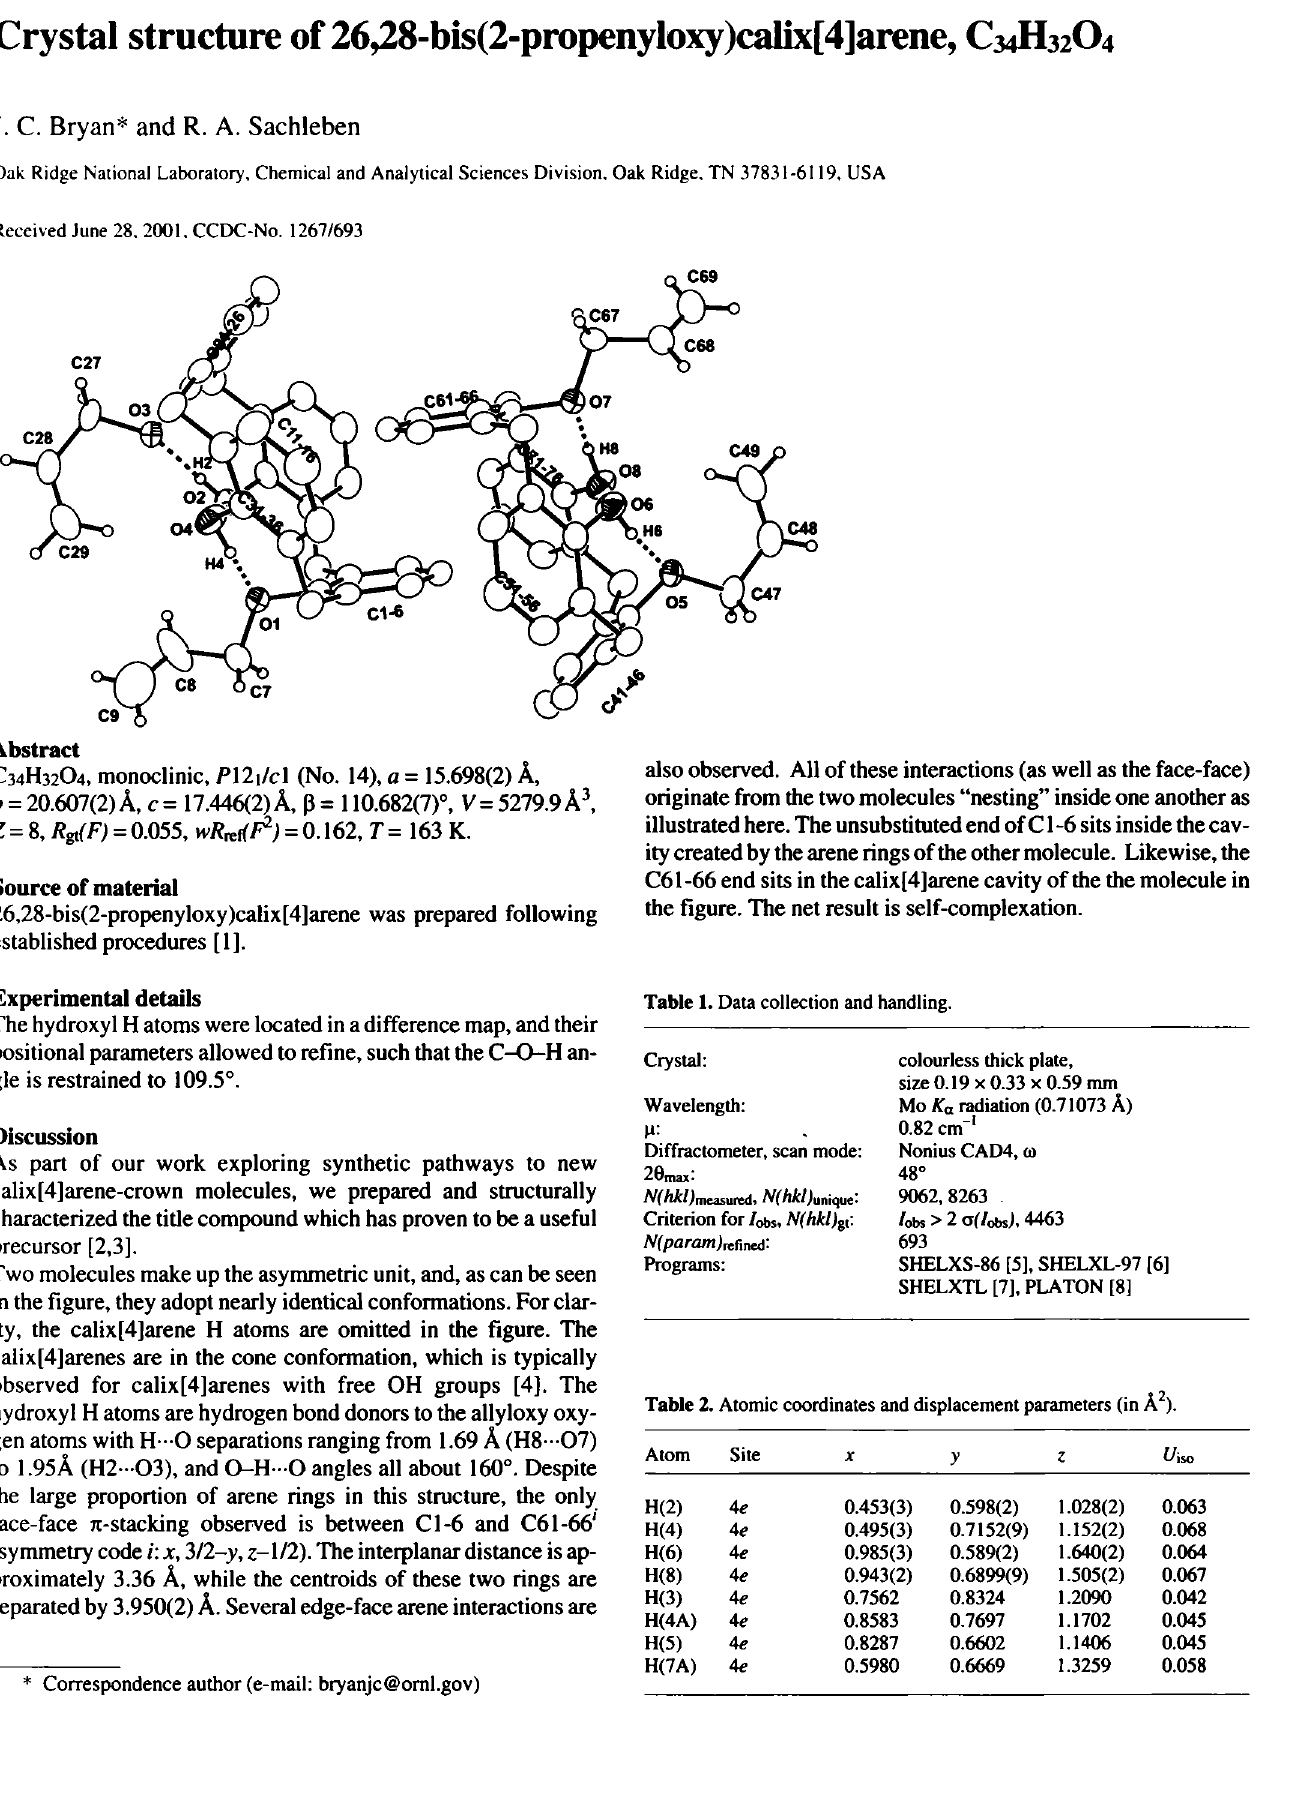
Table 2. Atomic coordinates and displacement parameters (in A 2